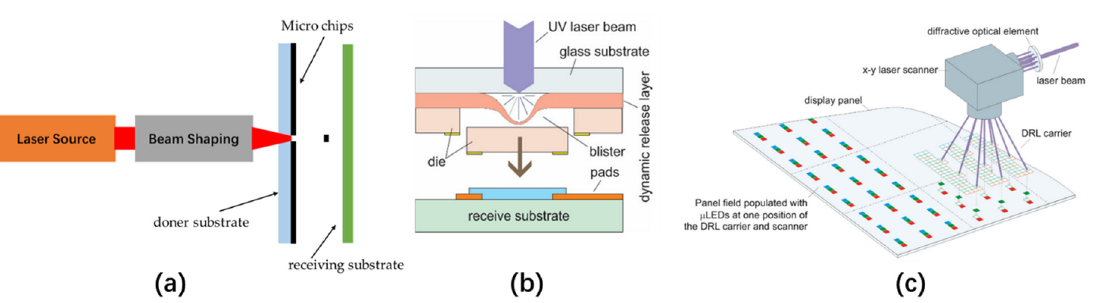
Figure 4. ( a ) Principle of laser-induced forward transfer technology. Reproduced from [43], with permission from Elsevier, 2016; ( b ) principle of massively parallel laser transmission technology launched by Uniqarta and ( c ) Massively Parallel Laser-Enabled Transfer (MPLET) technology that uses diffractive optical elements to transmit multiple pixels in parallel. Reproduced from [44], with permission from John Wiley and Sons, 2018.